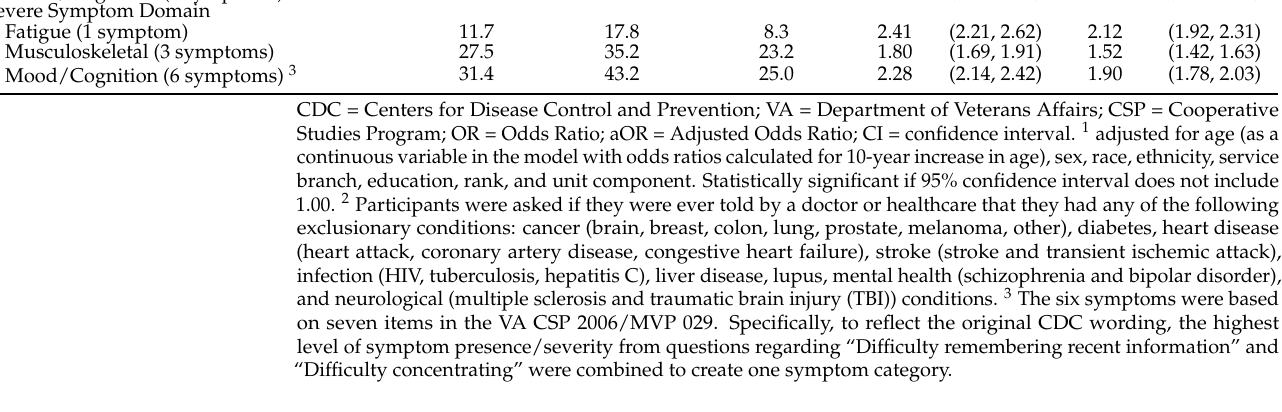
Table A7. Complete Case Analyses for Frequency and Associations of Veteran-Reported Exclusionary Conditions by 1990–1991 Gulf War Deployment